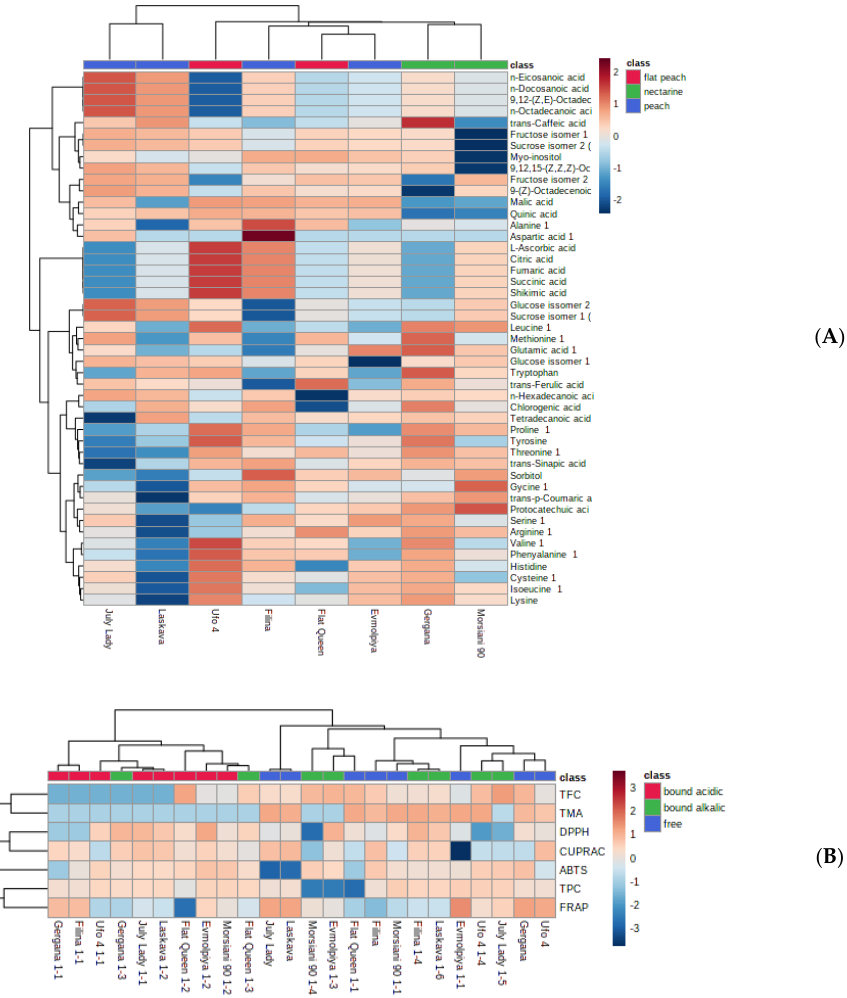
Figure 5. Heatmap of the clustering result of peach peels from eight varieties. ( A ) GC-MS data of volatile compounds and ( B ) TPC, TMA, TFC, and AOA assays. Values were normalized by log 10 transformation.